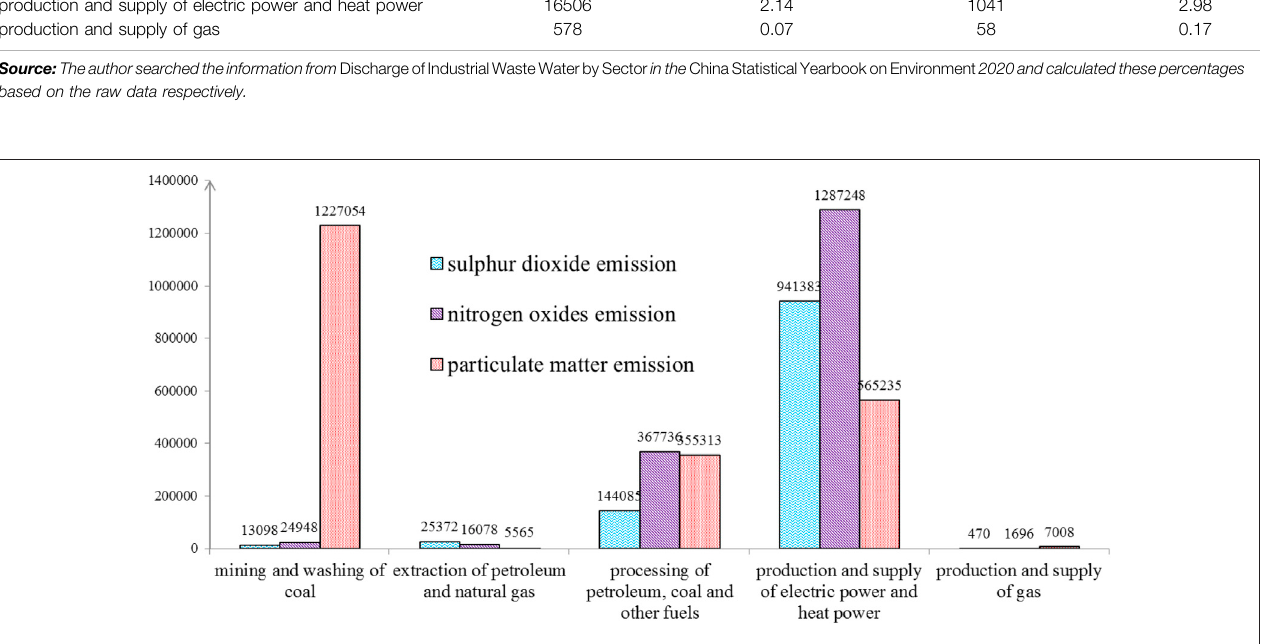
Frontiers in Environmental Science |